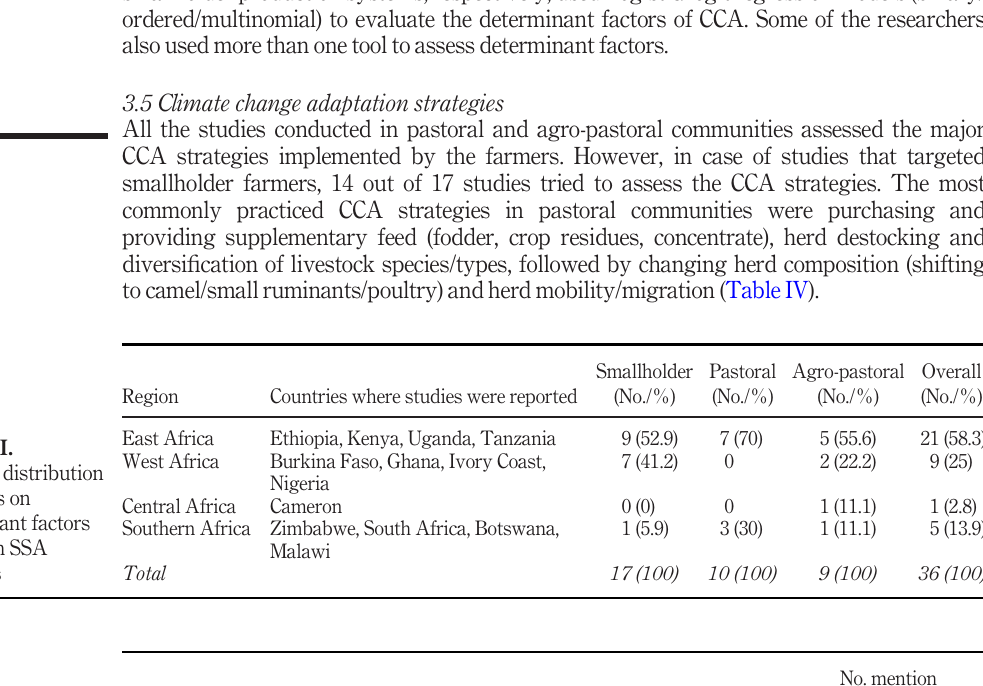
Adaptation strategies